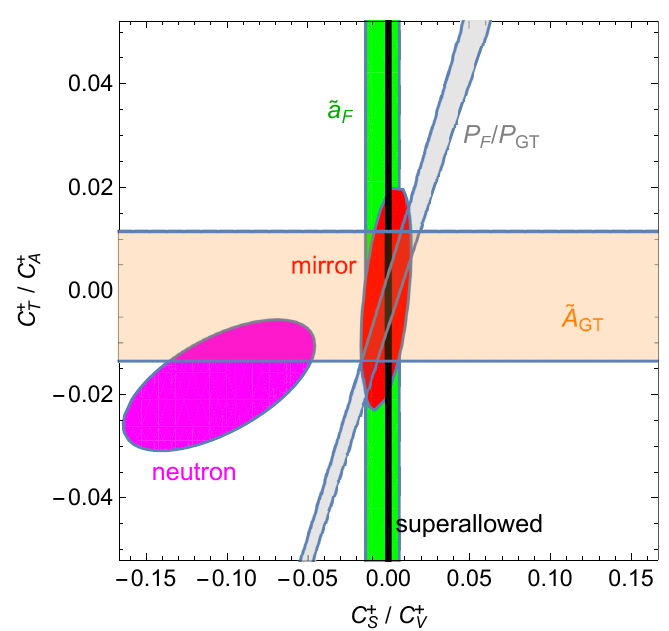
Figure 2 . 1 σ constraints on scalar and tensor coefficients using different subsets of beta decay data. The measurement of ˜ a ( 6 He) does not exclude any portion of the region shown in this plot. See appendix B for details about the various data